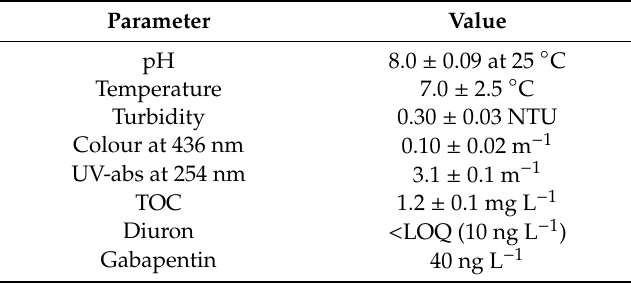
Table 2. The characteristics of Lake Constance water.